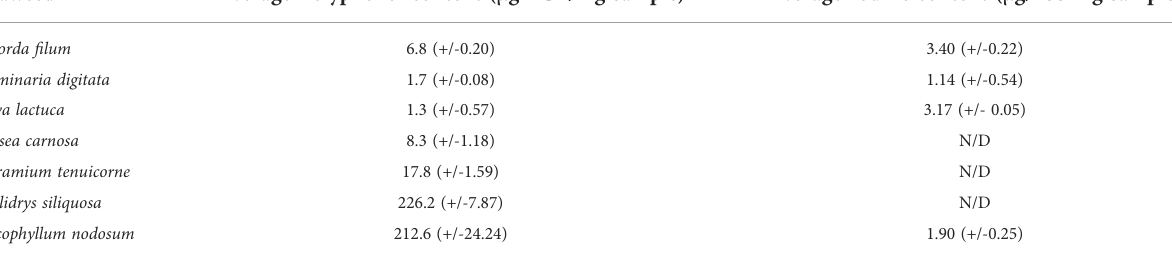
TABLE 3 Polyphenol and iodine content of Swedish seaweeds expressed in terms of phloroglucinol equivalents (µg PGE/mg sample) and µg iodine/100 mg of seaweed. Average and standard deviation (±) values shown (n = 3). N/D = Not detected.